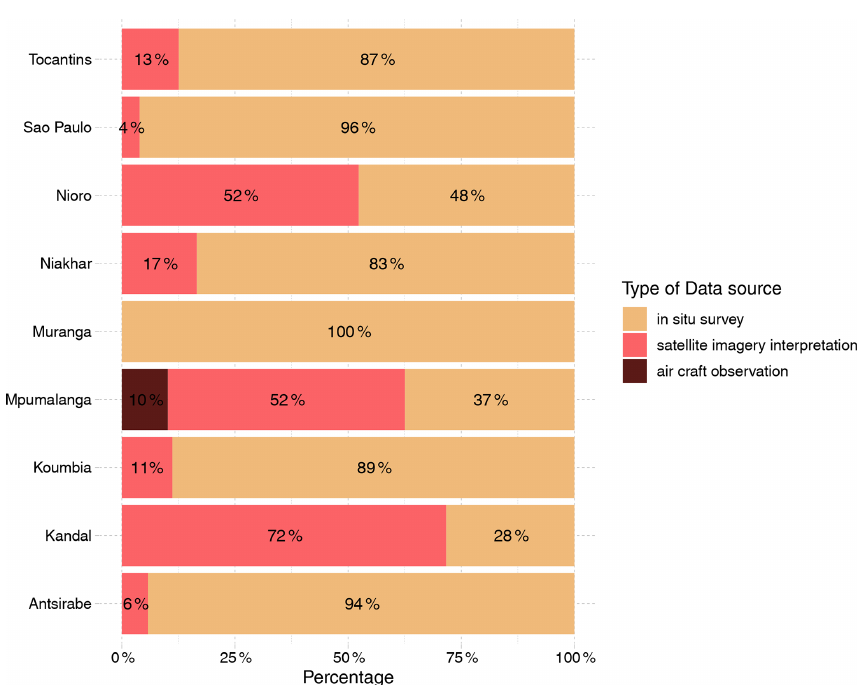
Figure 6. Distribution of the data sources, given in percentage of the total number of polygons per